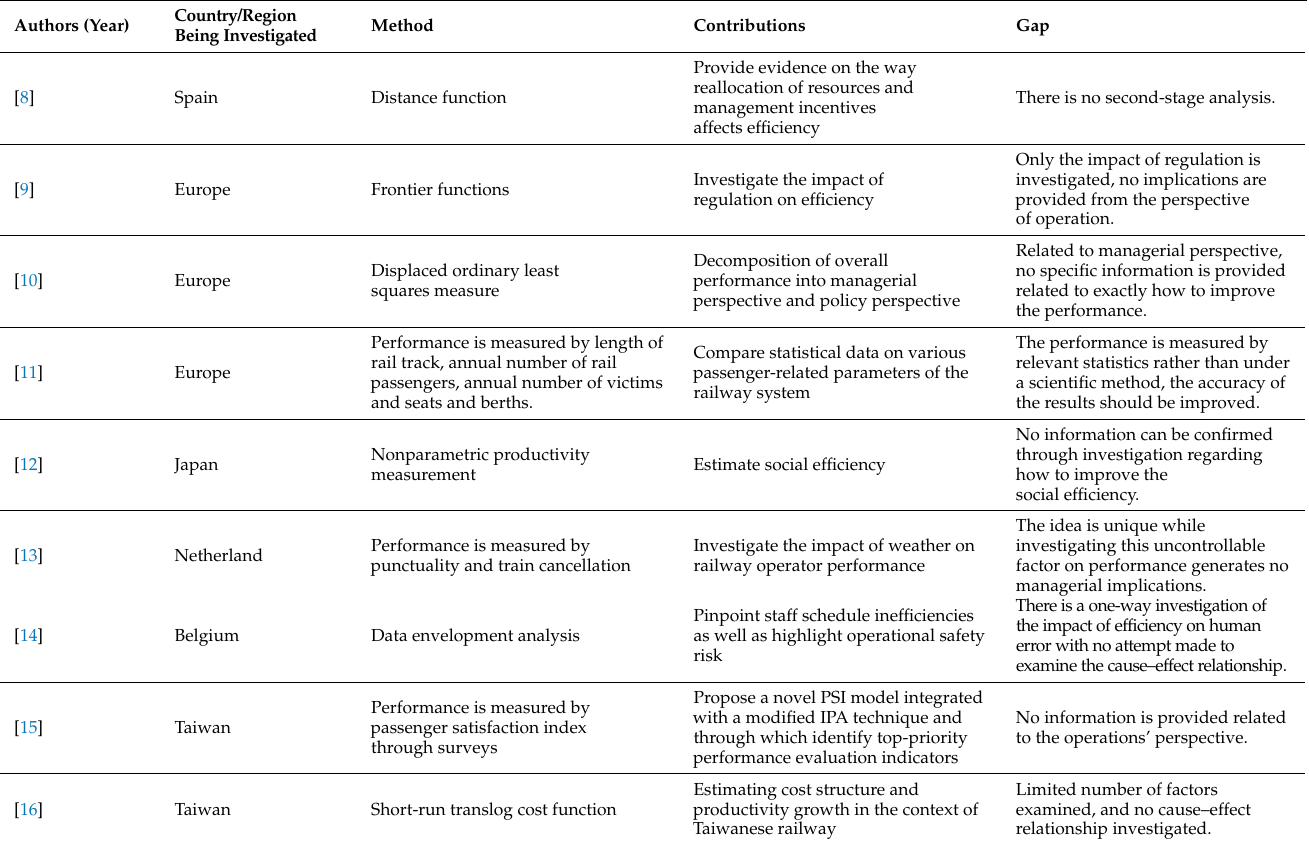
Table 1. Review of previous literature